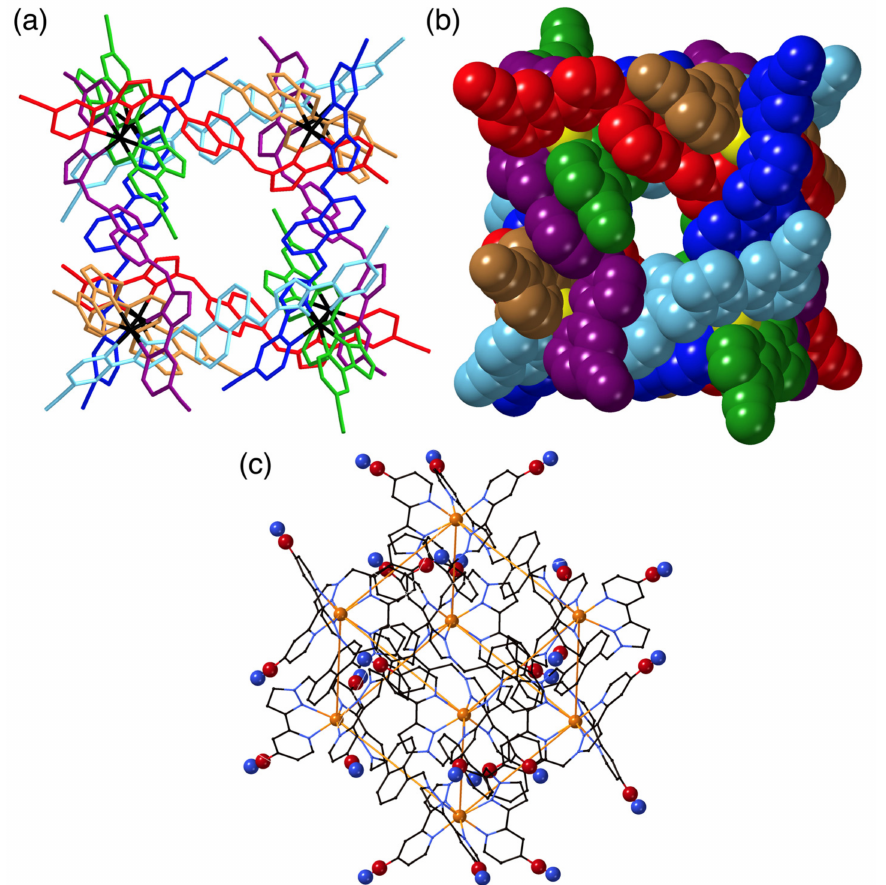
Figure 3. Three views of the crystal structure of the Cd(II) cage complex Cd • H CN . ( a ) A wireframe view with each ligand coloured separately for clarity; ( b ) a space-filling view with the cage in the same orientation, emphasising the intertwined nature of the ligands; and ( c ) a view with most of the cage in wireframe but the CN functional groups shown with larger spheres (C, red; N, blue), emphasising the pseudo-spherical array of 24 externally-directed CN